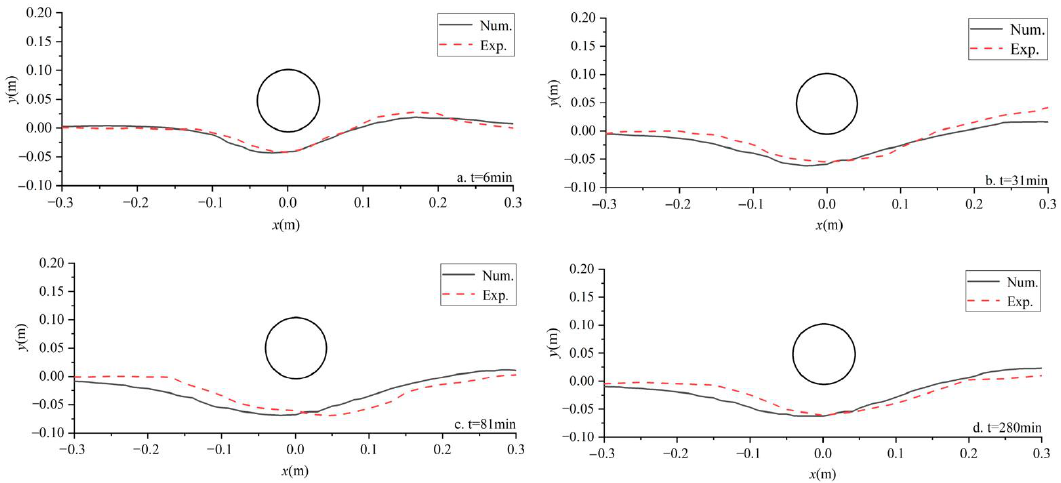
Figure 2. Pipeline equilibrium scour terrain and depth in live bed.